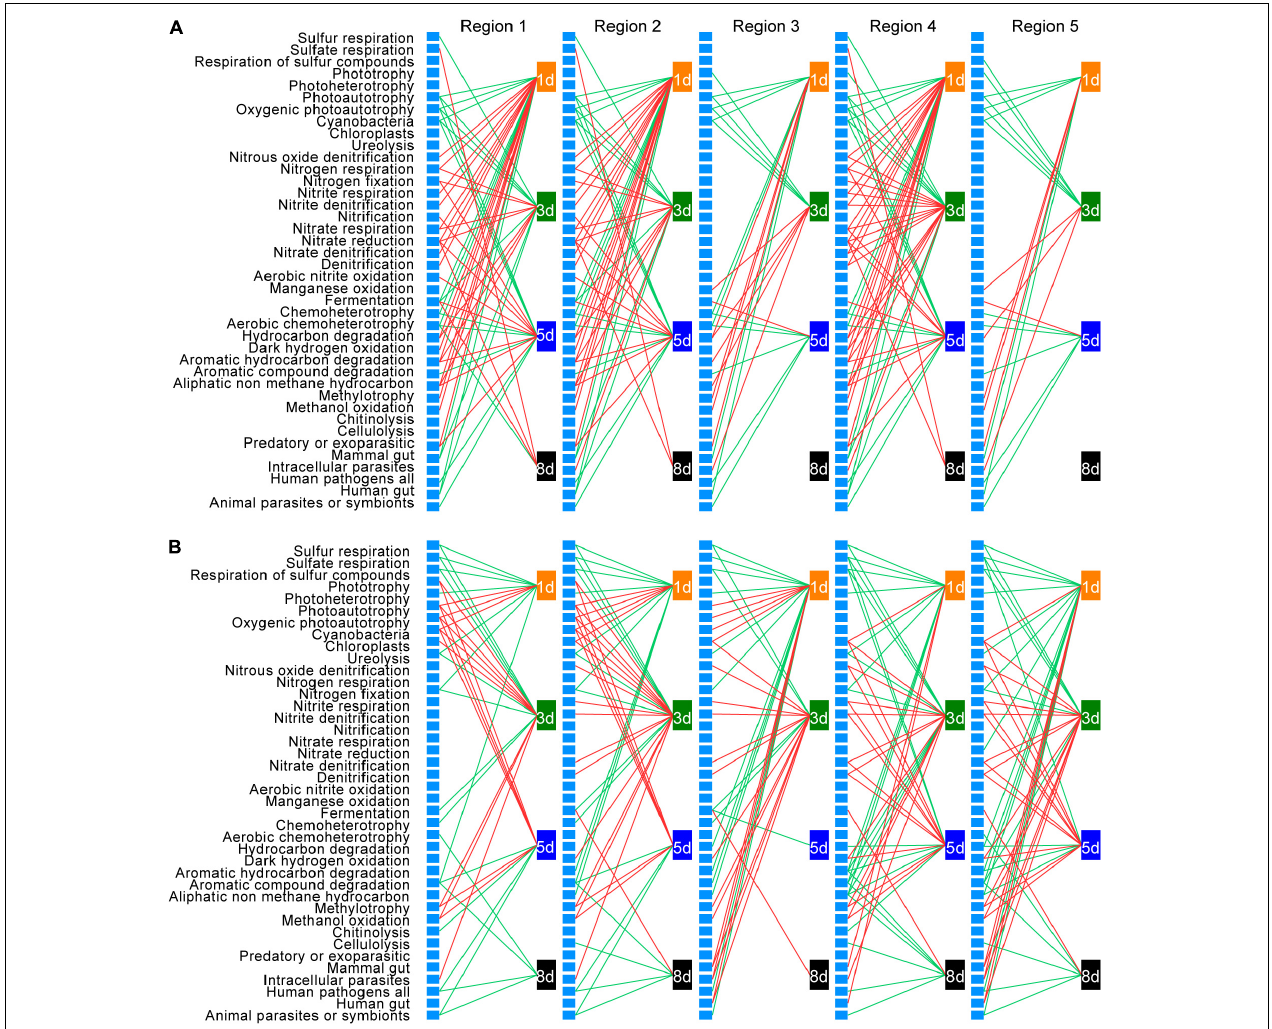
FIGURE 8 | Correlations between changes in the abundance of bacterial functional groups and changes in the amount of dissolved organic matter (DOM) in native soil (A) and non-native soil (B) . Only significant ( p < 0.05) correlations are shown. Red lines represent positive correlations, and green lines represent negative correlations. Each unlabeled rectangle represents a specific functional group. Each labeled rectangle represents a specific sampling time. The five groups arranged from left to right are the five types of DOM: tyrosine-like proteins (region 1), tryptophan-like proteins (region 2), fulvic acid-like organics (region 3), microbial byproduct-like materials (region 4), and humic acid-like organics (region 5).